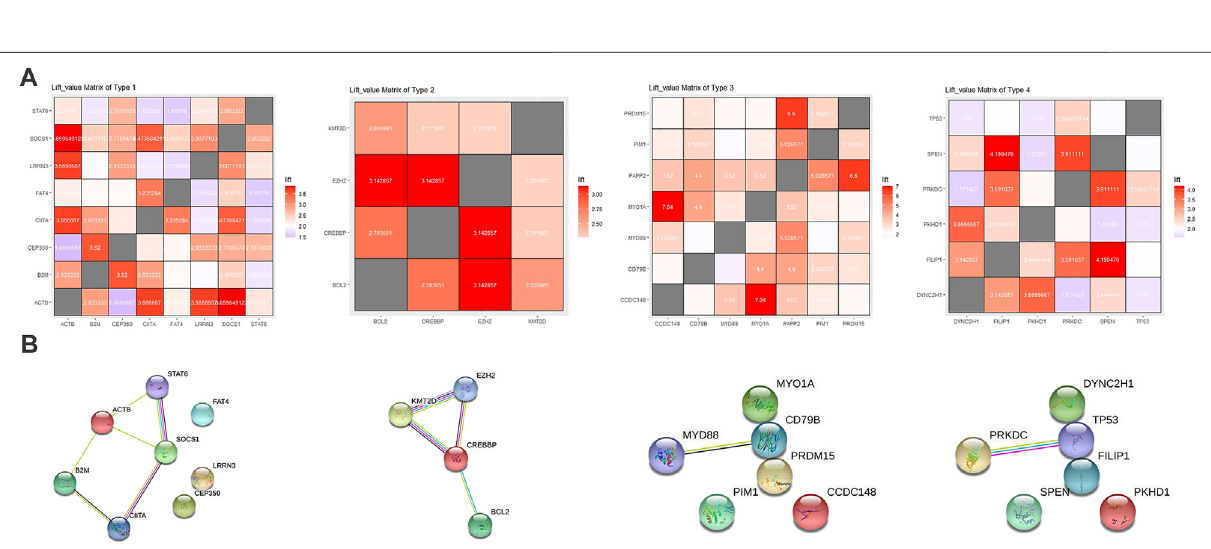
FIGURE 3 | (A) From left to right: Matrix heat map of lift values between genes in Type 1 – 4, and colors represent lift value. (B) From left to right: The protein interaction network of Type 1 – 4 mapped with the string online